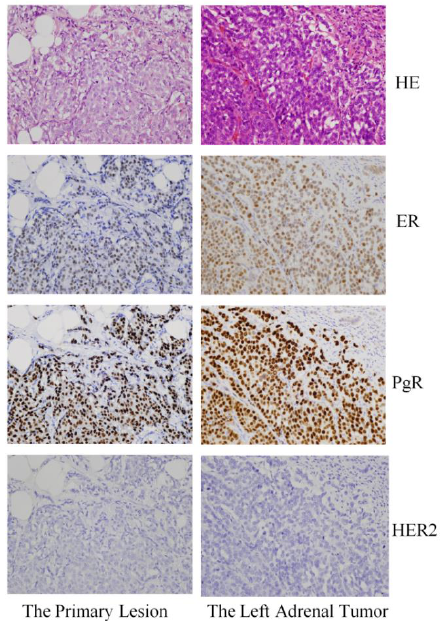
Figure 2. Pathological findings of the primary lesion (100× magnification): invasive